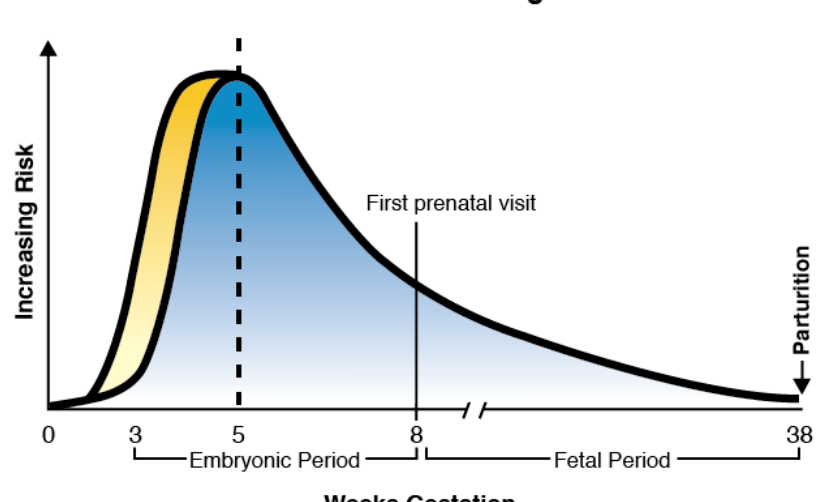
Figure 1. Graph showing susceptible period of teratogenesis when birth defects can be induced. Originally it was thought that the third to eighth weeks after fertilization were the most sensitive time (blue). However, recent advances in our understanding of key events regulating embryogenesis, especially those involving axes formation, has demonstrated the period of greatest susceptibility should include at least the second week and probably the first as well (yellow).